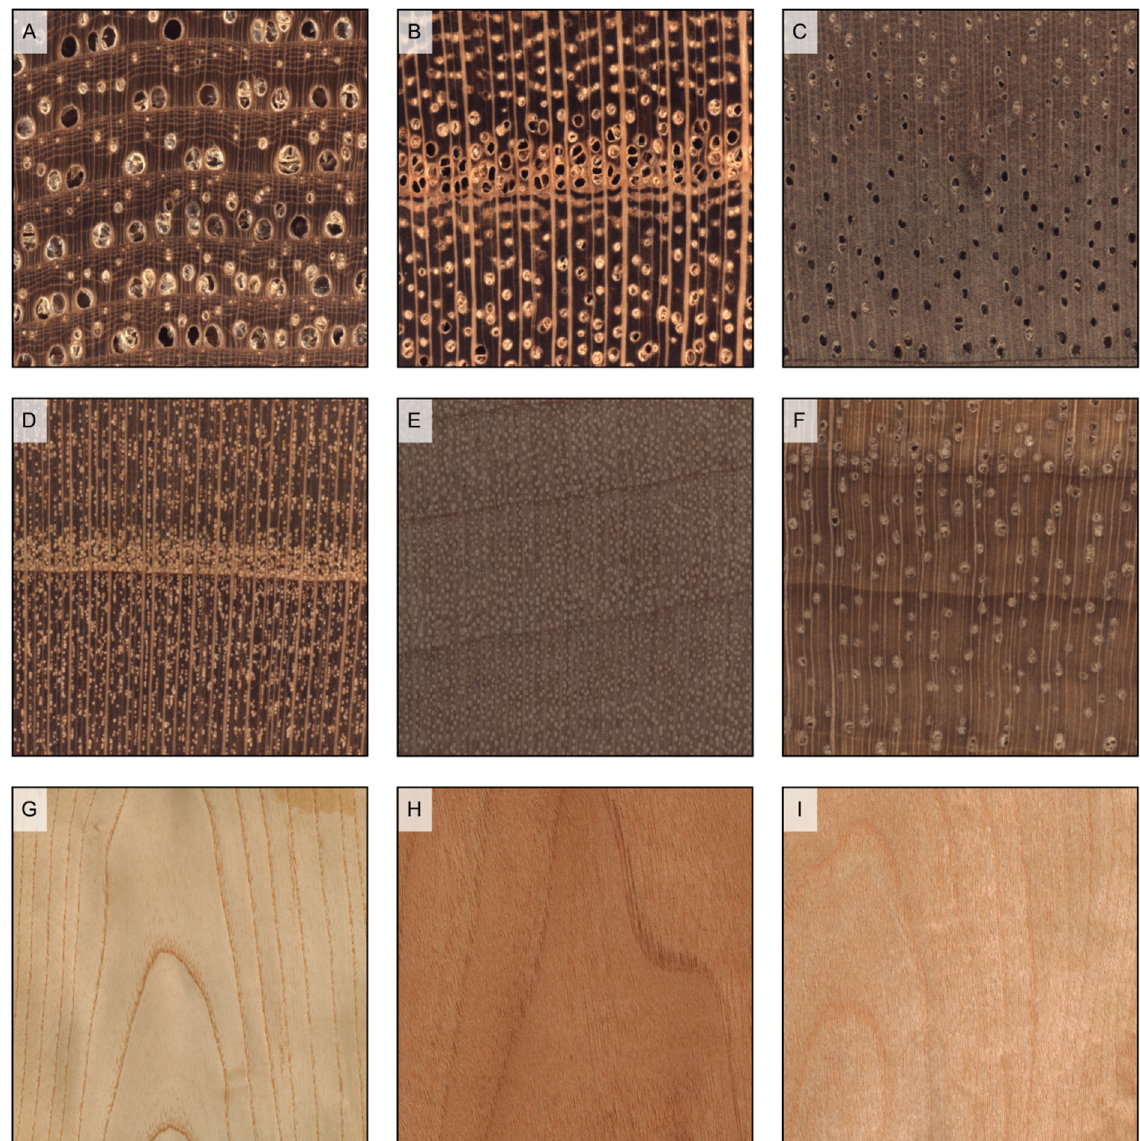
Figure 6. Wood porosity (( A–F ) transverse sections, ( G–I ) tangential sections). ( A ) ring-porous, one row only of earlywood vessels, widest tangential spacing between earlywood vessels: more than one earlywood vessel ( Carya ovata ); ( B ) ring-porous, more than one row of earlywood vessels, widest tangential spacing between earlywood vessels: one earlywood vessel at most ( Gleditsia triacanthos ); ( C ) semi-ring porous, vessels’ diameter gradually narrows from earlywood to latewood ( Juglans regia ); ( D ) semi-ring porous, vessels are of the same diameter as latewood ones but much more closely spaced ( Prunus avium ); ( E ) diffuse porous, vessels are small ( Acer rubrum ); ( F ) diffuse porous, vessels are medium ( Astronium graveolens ). The figure consequent to growth rings is evident in ring-porous woods (( G ) Fraxinus excelsior ), visible in semi-ring porous woods (( H ), Juglans regia ), and faint in diffuse porous woods (( I ), Betula pendula ).